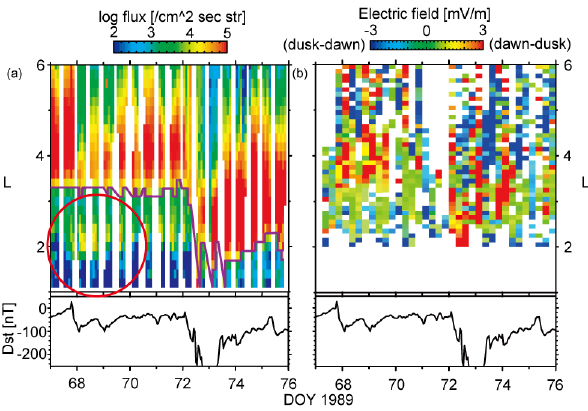
Fig. 1. L-t diagram of 300keV electron flux observed by NOAA (a) and variation of convection electric fields at the magnetic equa- tor (b) during the period from day 67 to day 76 of 1989. The bottom panels show the D st